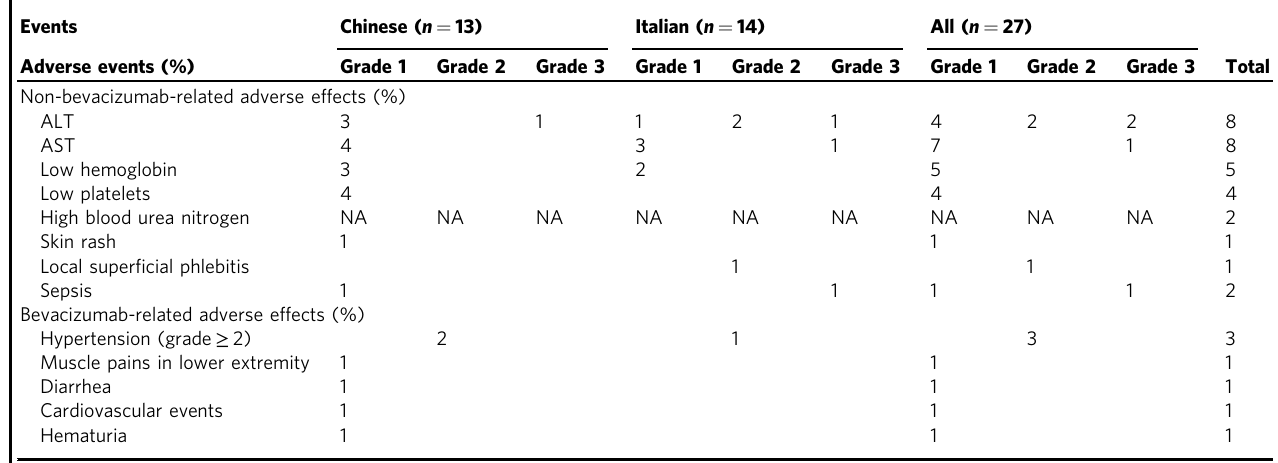
Table 3 Summary of adverse